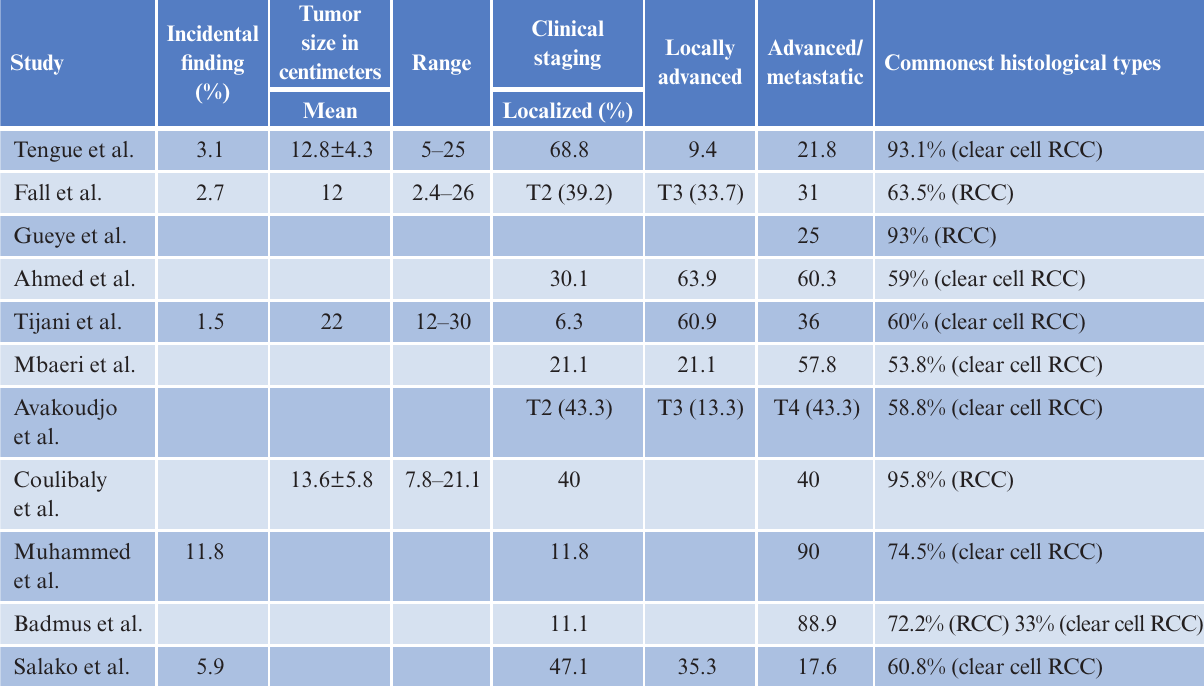
Table 3: Renal tumor size, clinical staging, and commonest histological types in sub-Saharan Africa